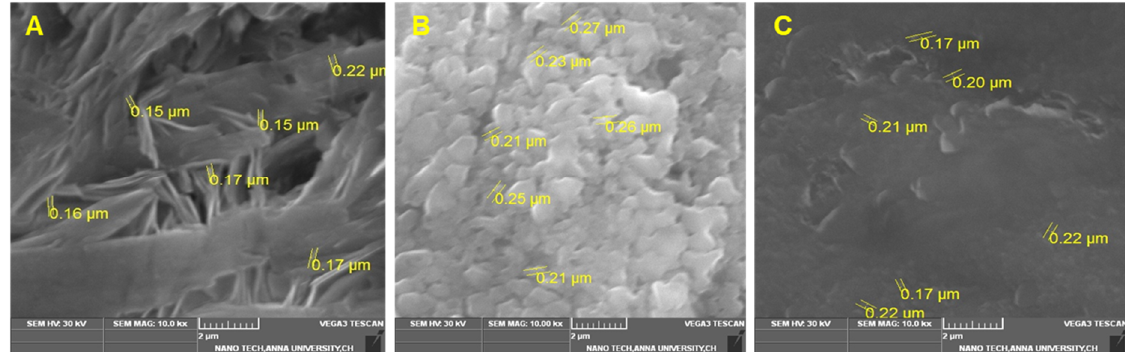
Figure 3. SEM images of biogenic CuNPs prepared with extracts of spices. ( A ) Nutmeg (150 nm to 220 nm), ( B ) star anise (210 nm to 270 nm), and ( C ) mace (150 nm to 220 nm).